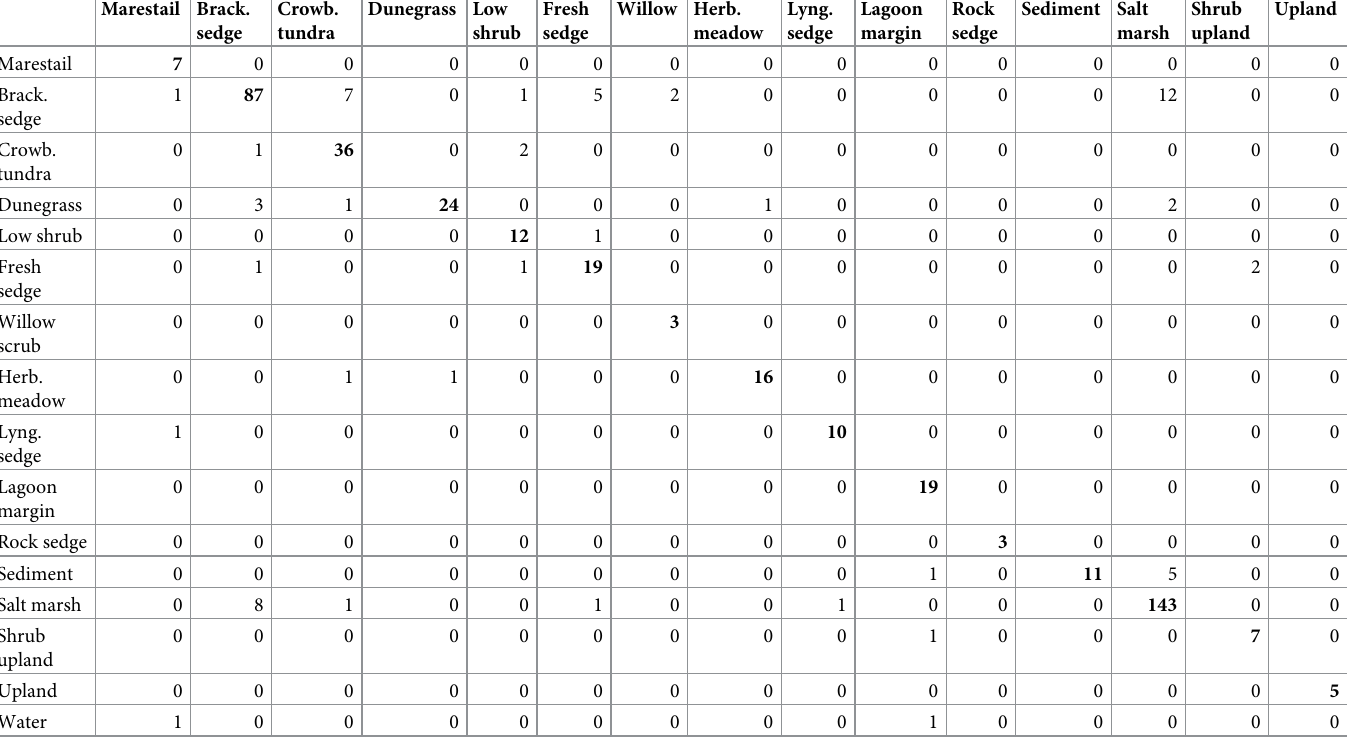
Table 6. Error matrix for the field test